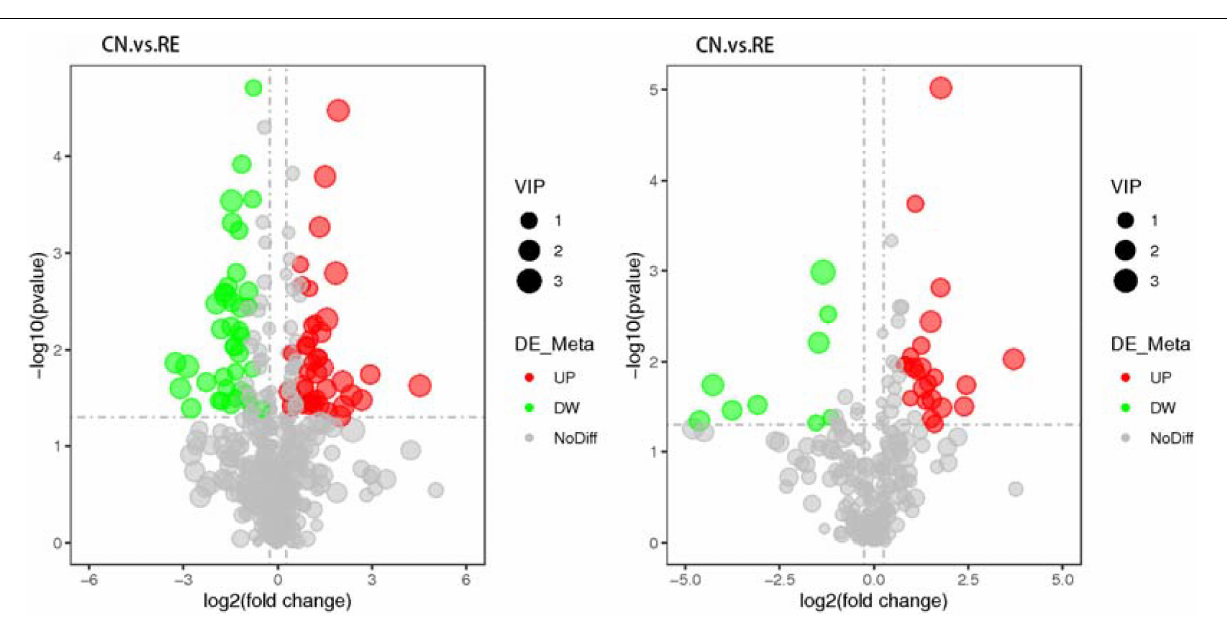
FIGURE 2 | Volcanic map of differential metabolites (positive ion mode on the left and negative ion mode on the right). The X-axis represents the expression multiple change (log2FoldChange) of metabolites in different groups; and the Y-axis represents the significance level of difference (–log10p-value). Each point in the volcanic map represents a metabolite; the significantly upregulated metabolites are represented by red dots, whereas the significantly downregulated metabolites are represented by green